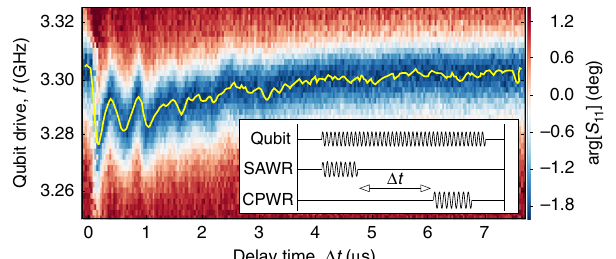
Fig. 5 Time-delayed acoustic Stark shift. Measured time-delayed acoustic Stark shift of the qubit. The yellow solid line indicates the qubit frequency. Inset: pulse scheme related to this experiment: a continuous drive excites the qubit, while two short 100 ns pulses delayed by Δ t drive the SAWR and the CPWR for